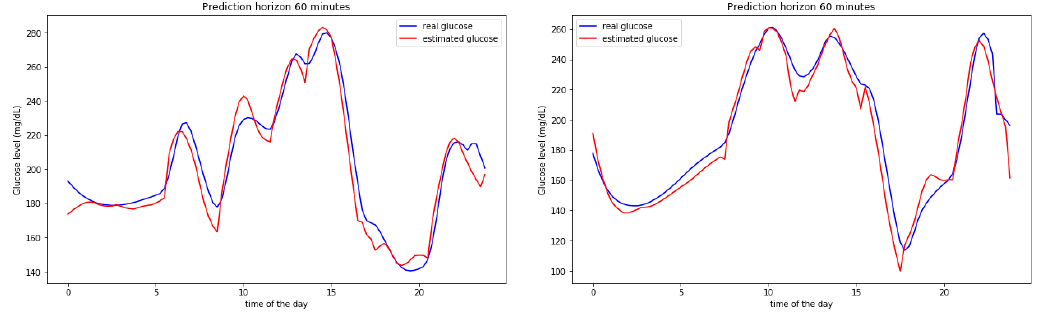
Figure 3. Predictions on a 60 min horizon for 8 days for a simulated participant.